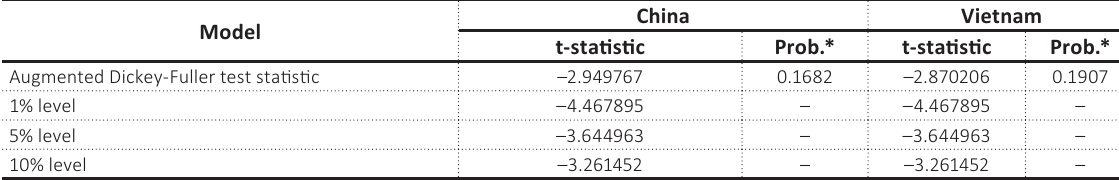
Table 3. Lending rates: 0-degree difference test – I(0)